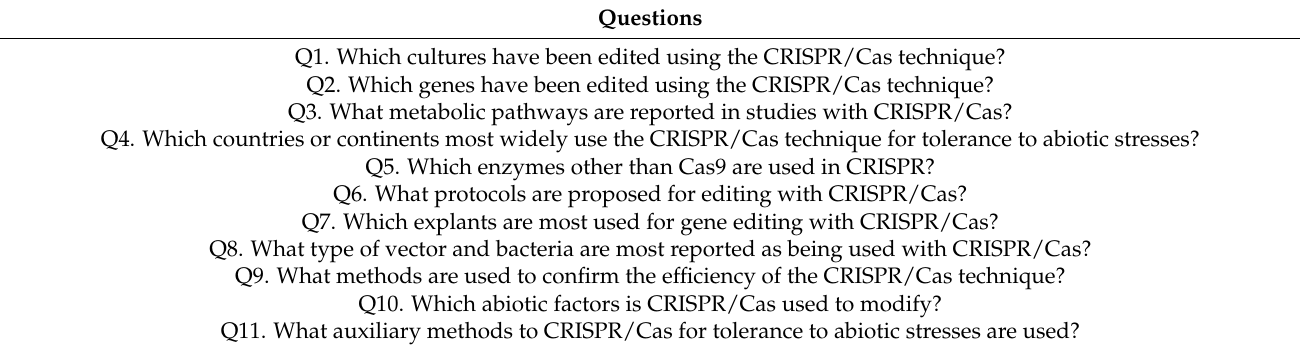
Table 2. Questions about using CRISPR/Cas technology to edit genes for tolerance to abiotic stresses in a systematic review of studies published in the last seven